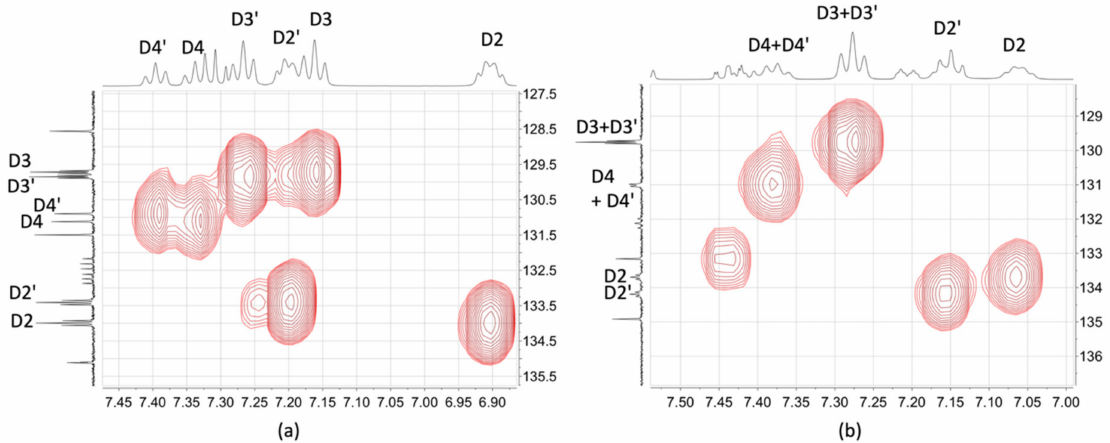
Figure 5. Part of the HMQC spectra ( 1 H 500 MHz, 13 C 126 MHz, acetone-d 6 , 298 K) of ( a ) [Cu(xantphos)( 1 )][PF 6 ] and ( b ) [Cu(POP)( 1 )][PF 6